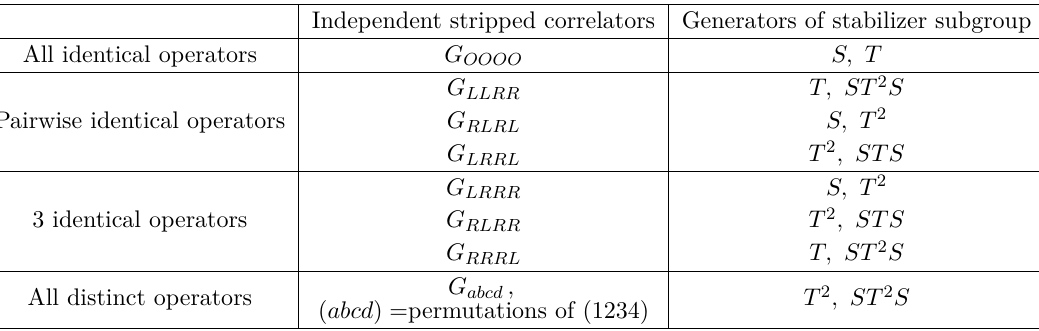
Table 1 . List of possible stabilzer